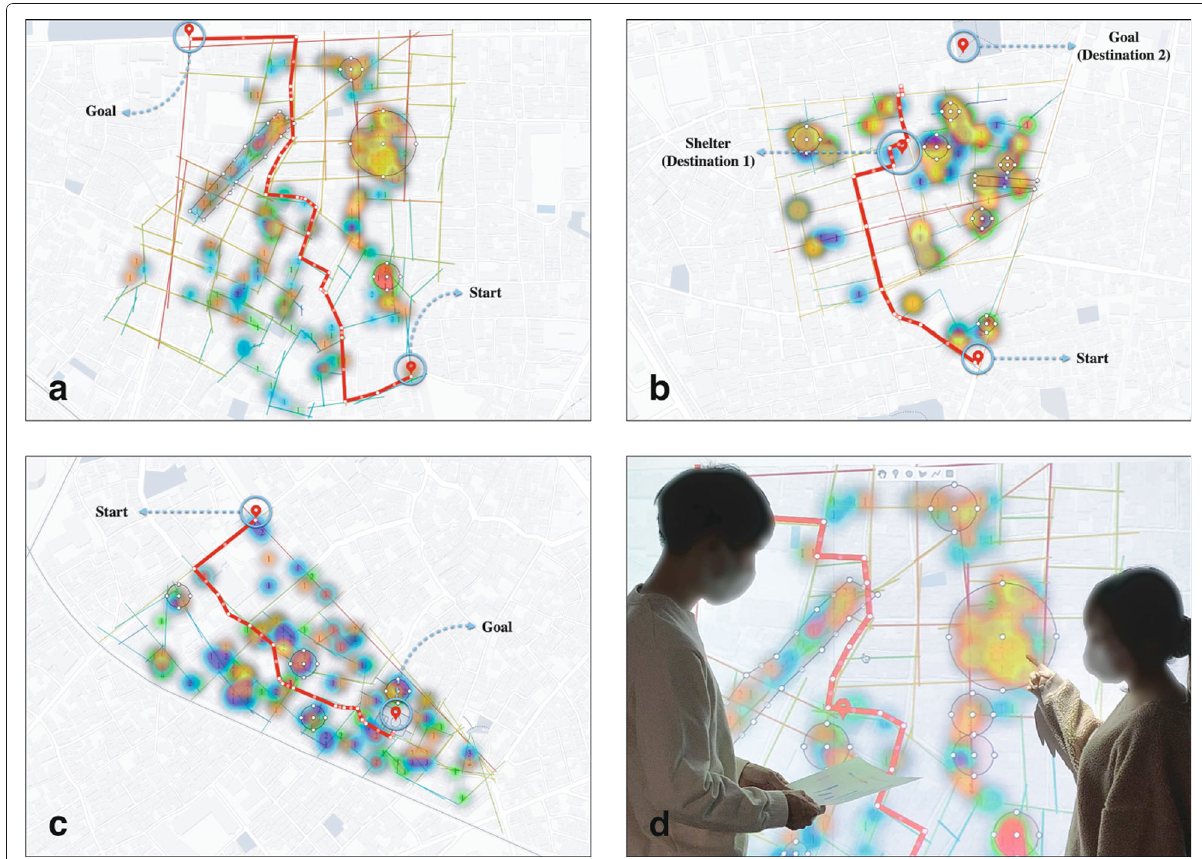
Strongly Strongly disagree agree 1 2 3